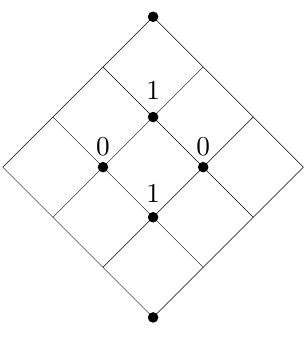
Figure 3. Limiting Hodge diamond for Type IV 1 .